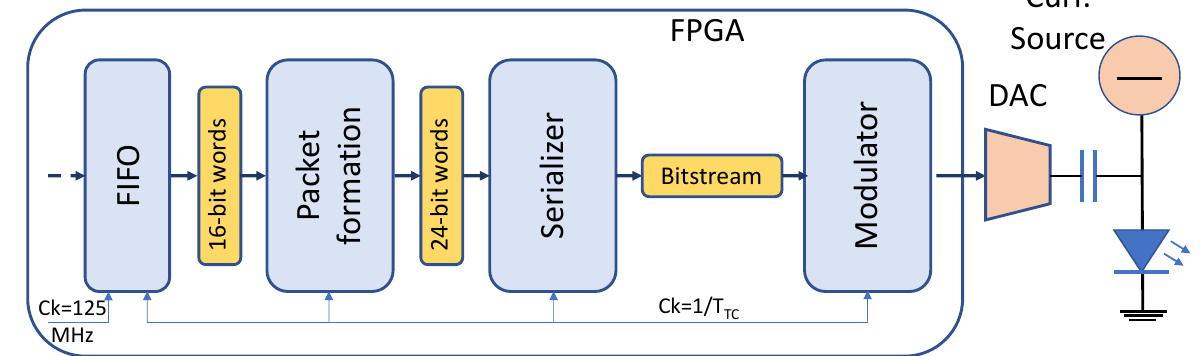
Figure 5. Architecture of the transmitter.